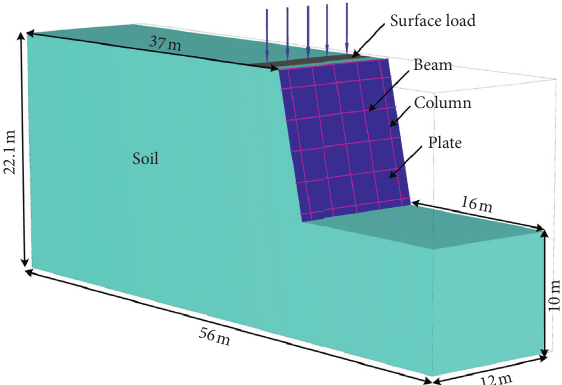
Figure 5: Slope support model.